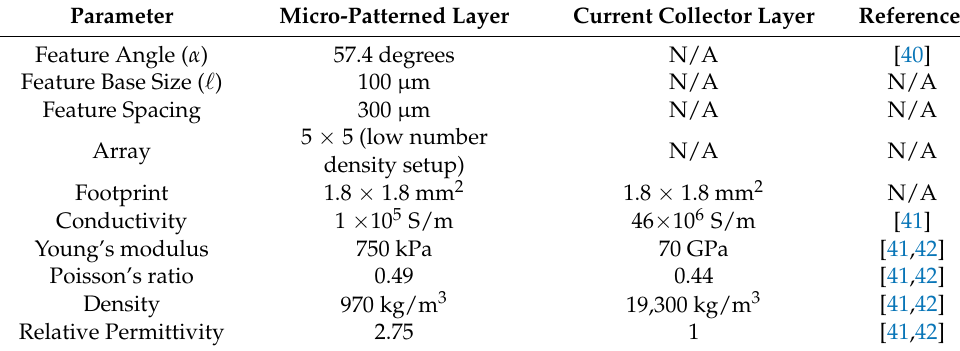
Table 1. Simulation